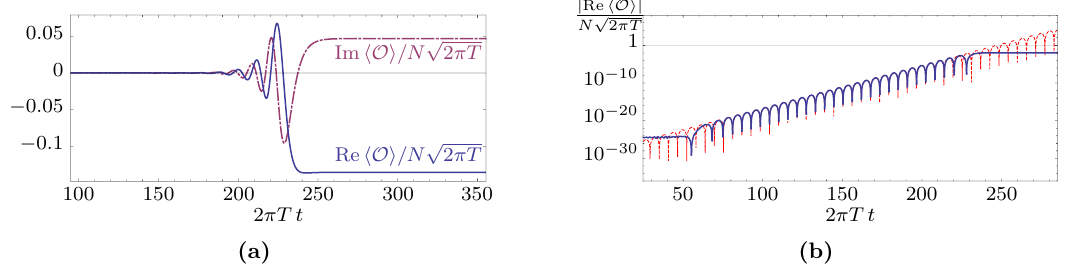
Figure 2. Time evolution of the real and imaginary part of hOi (a), and the normalised absolute value of Re hOi (b) for the normal-to-condensed quench, (cid:20) nc (cid:12)t to the unstable QNM behaviour of the form given by eq. (3.1), with ! I >